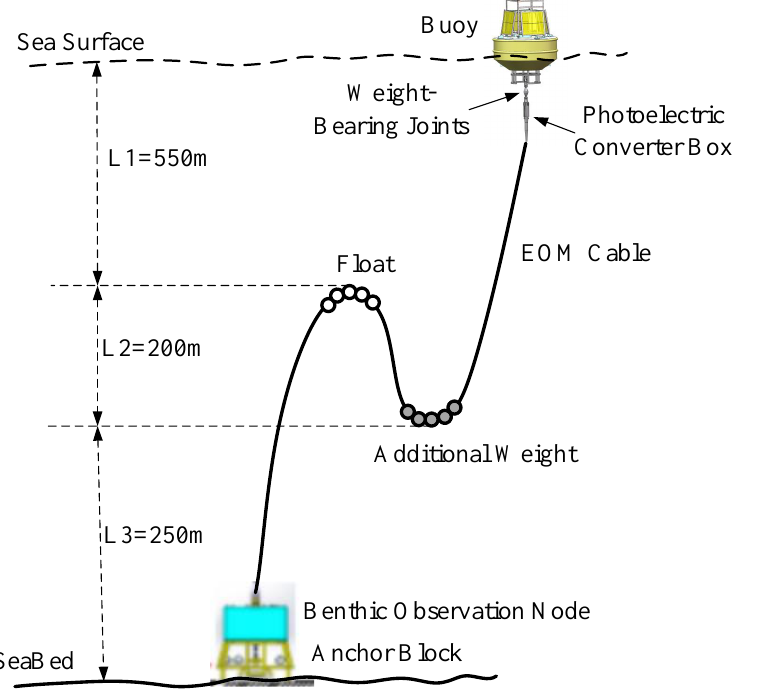
Figure 8. S-type mooring in 1000 m depth with 1400 m Electro-Optical-Mechanical (EOM) cable.